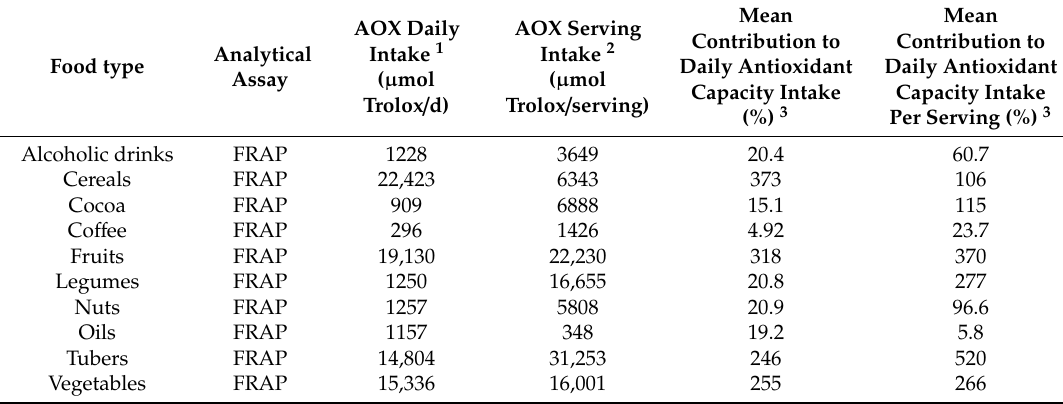
Table 1. Contribution of plant foods consumption to the daily antioxidant capacity (AOX) in the Spanish diet.